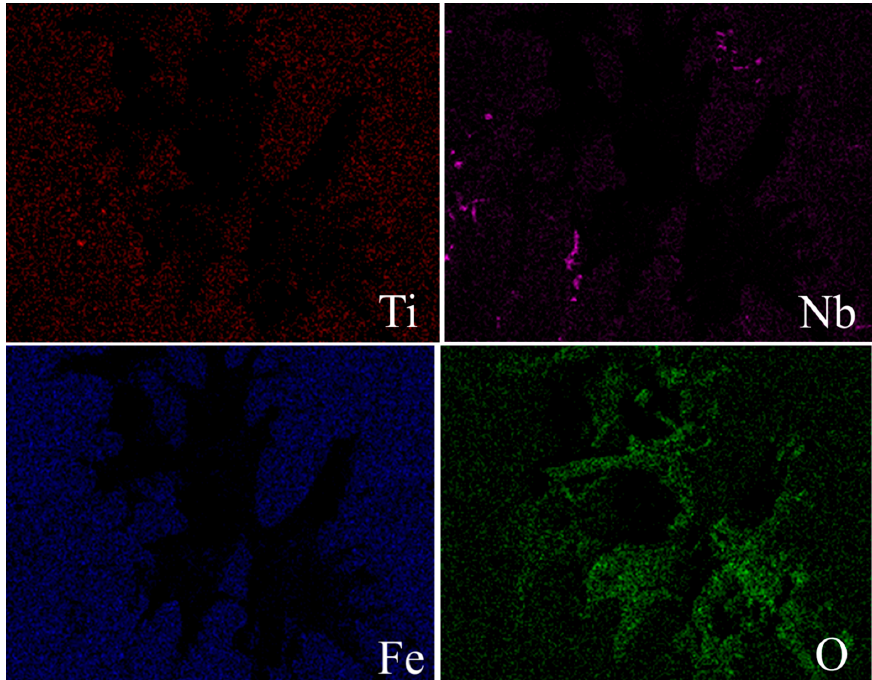
Figure 10. The elements mapping of the superalloy around a microporosity of one.